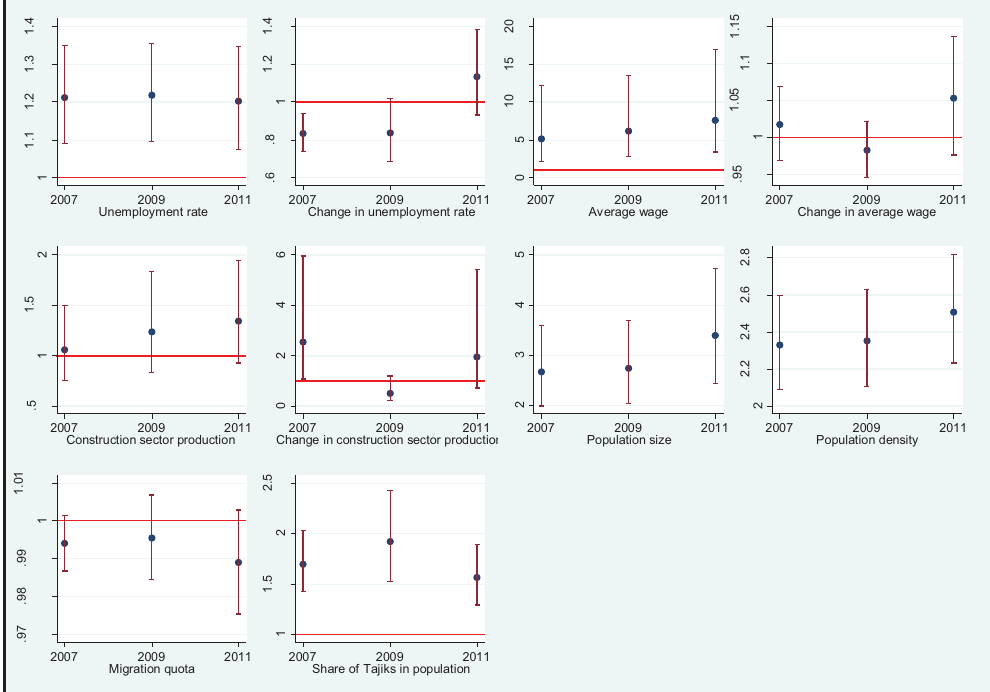
Figure 1 Odds ratios of regional characteristics in 2007, 2009, and 2011. Note: 95% confi- dence intervals